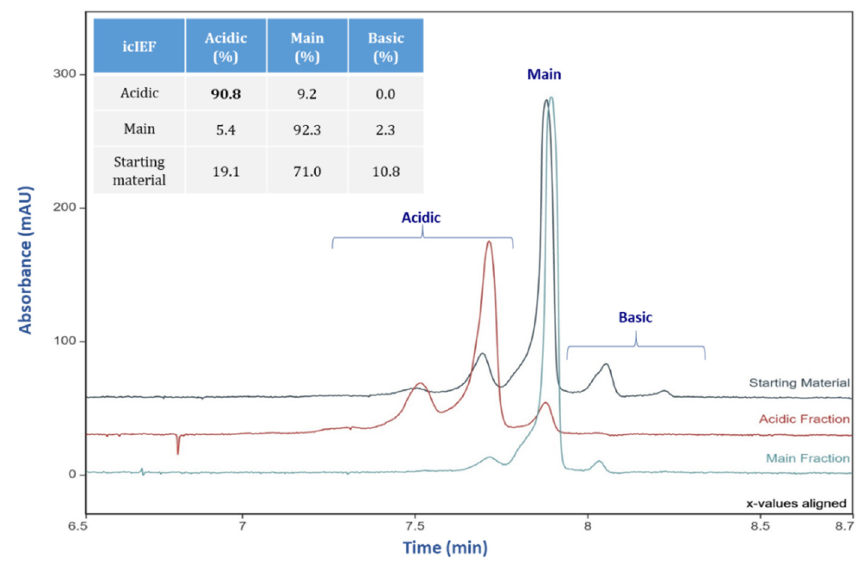
Figure 3. icIEF Electropherogram overlays of mAb starting material ( teal ), the acidic fraction ( mango ), and the main fraction ( blue ). An inserted table listed the levels of acidic, main and basic species measured by icIEF.